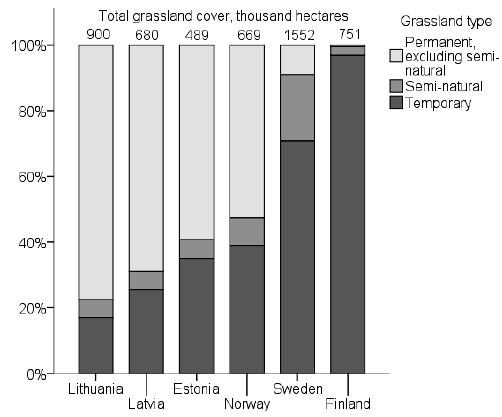
Fig. 1 . Relative areas for three grassland types: permanent (excluding semi-natural grassland), semi-natural, and temporary (rotational, five or less years on one field parcel) grasslands in the boreal countries of northern Europe. Only areas that are managed either for production or as part of agricultural policy requirements are included.